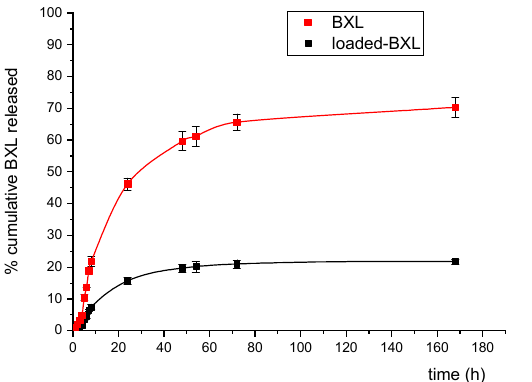
Figure 1. In vitro BXL release profile. In red is reported the quantification of BXL released from the formulation. In black is reported the quantification of BXL released based on the entrapment efficiency. The data plotted are means ( n = 3) ± SD.